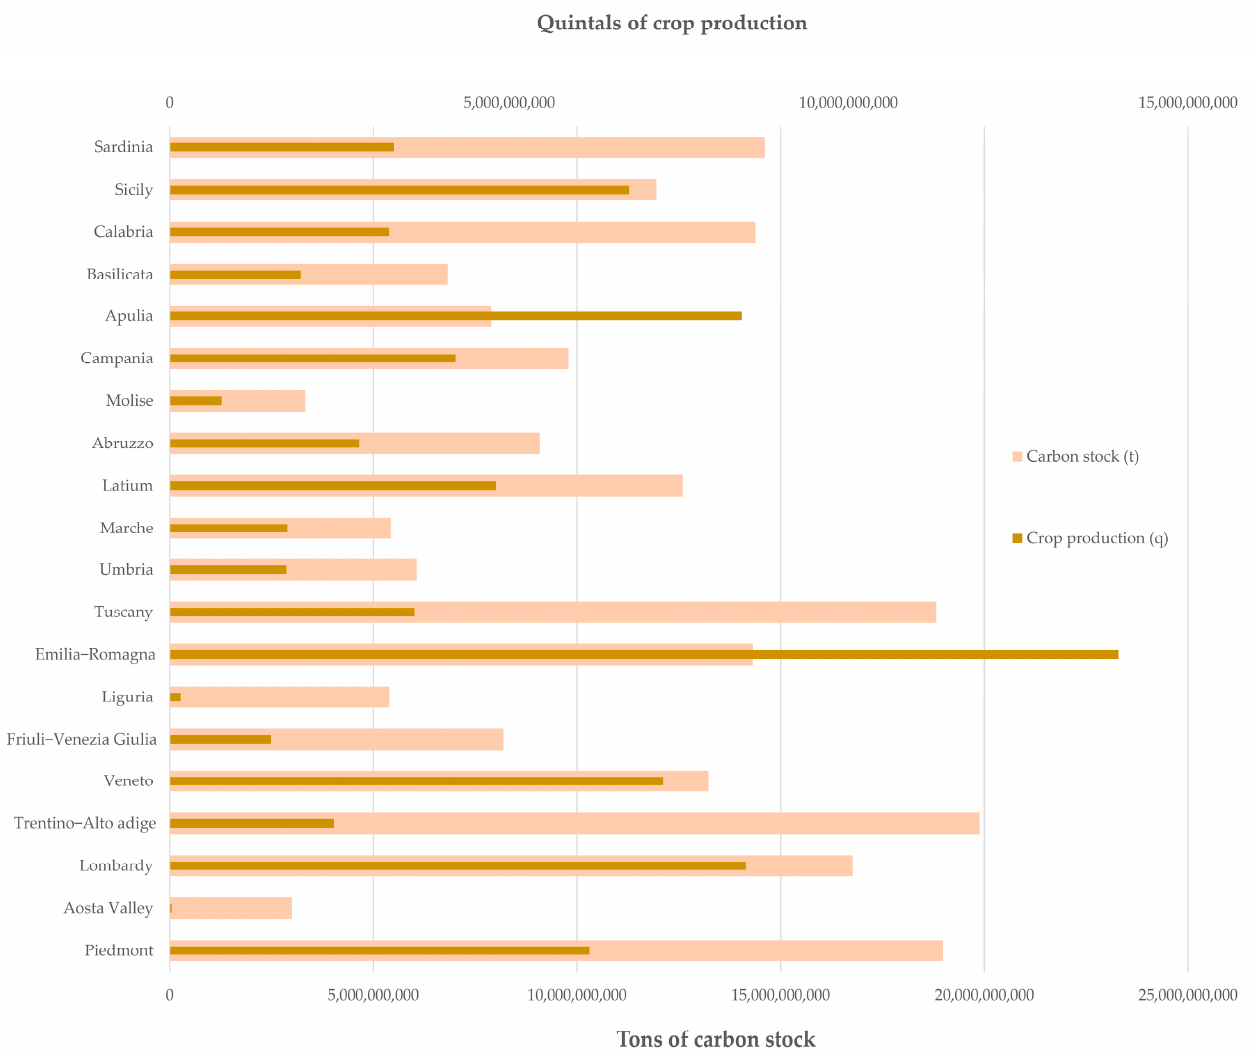
Figure 7. National and regional values of crop production and carbon stock (2018).